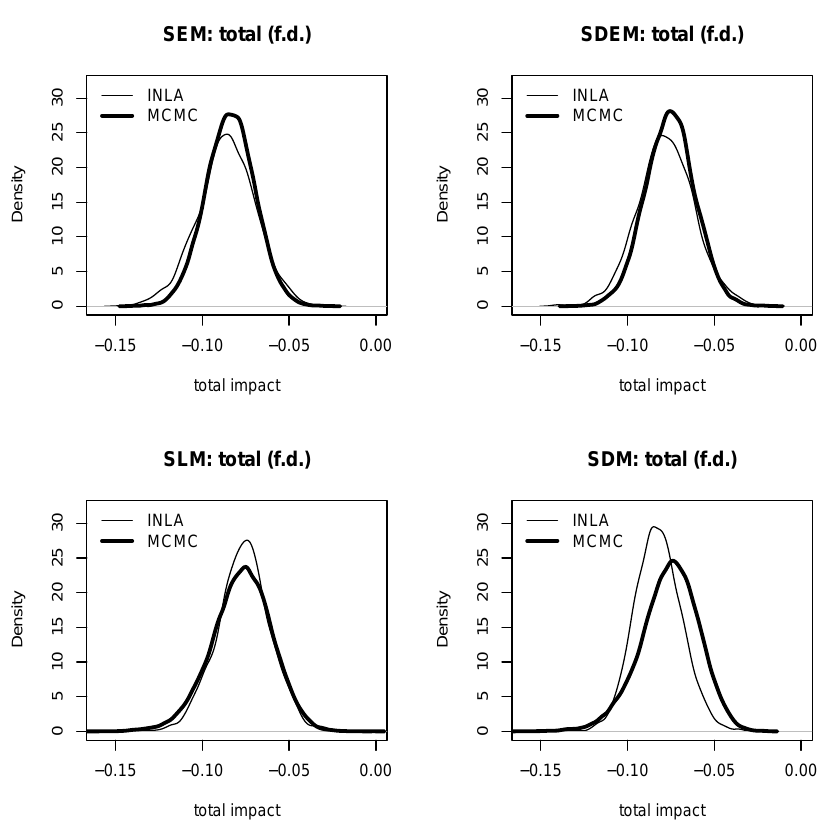
Figure 8. Average total impacts for flood depth for the Katrina data